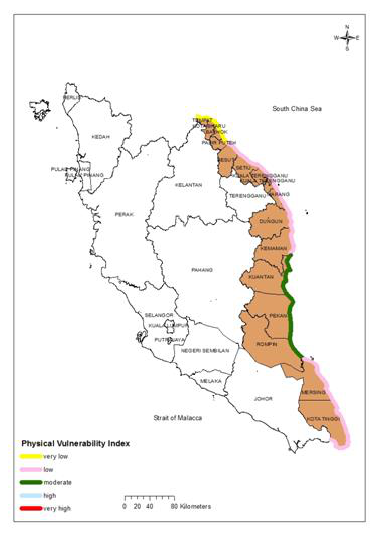
Figure 1: Physical Vulnerability Index map. The red color shows the most vulnerable followed by blue (high), green (moderate), pink (low) and yellow (very low). The districts along the coastal are colored by dark